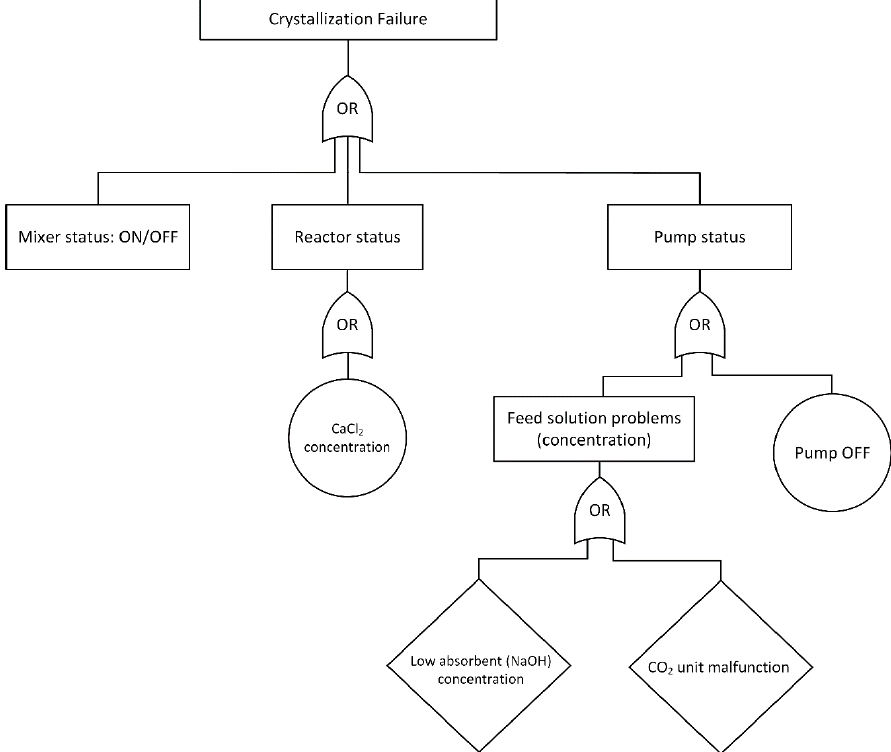
Figure 3. Fault tree analysis diagram for the integrated CO 2 capture and reactive crystallization process of calcium carbonate.